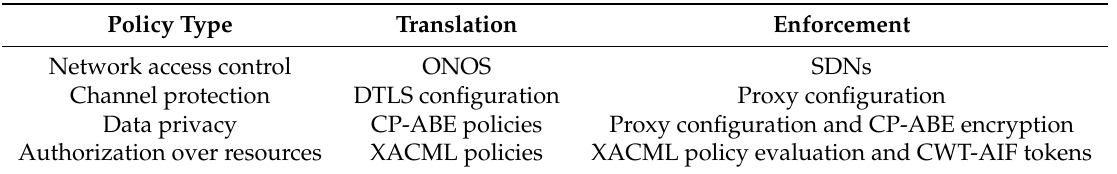
Table 1. Overview of the security